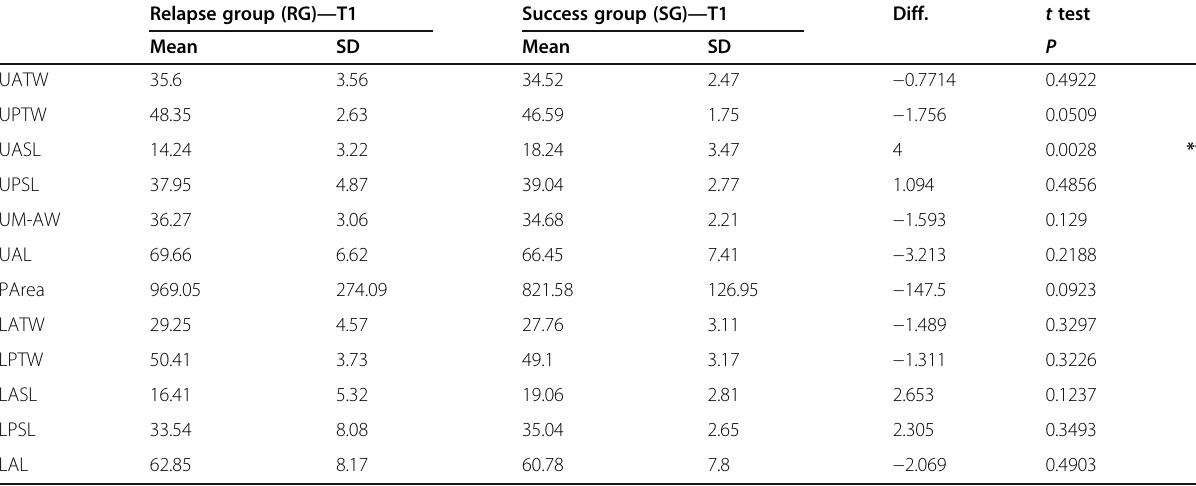
Table 6 Statistical comparisons between groups at T1: digital dental casts measurements Relapse group (RG) — T1 Success group (SG) — T1 Diff. t